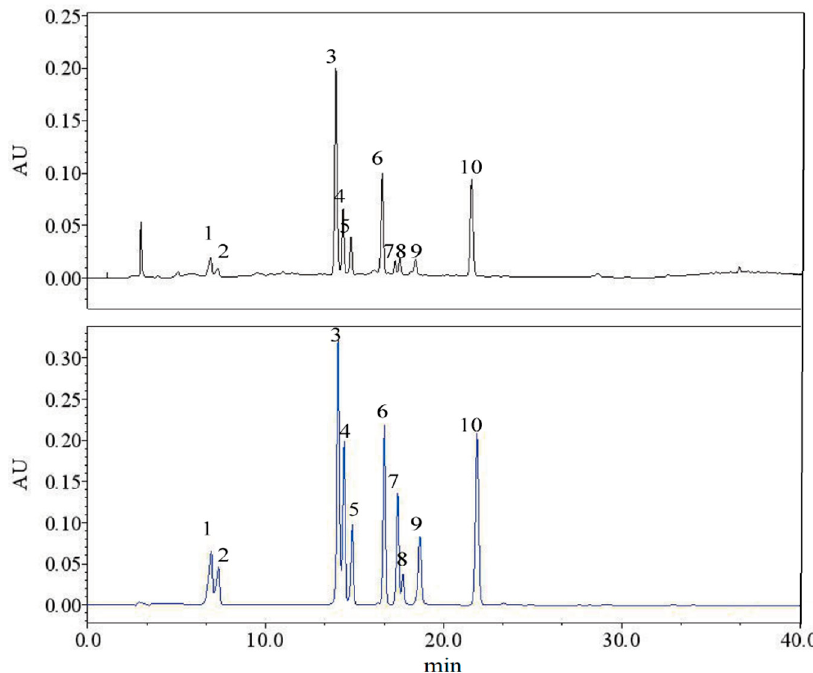
Figure 1. The representative HPLC chromatograms of C. paliurus leaf extract (top) and a mixed standards (bottom). 1. 3- O -caffeoylquinic acid; 2. 4- O -caffeoylquinic acid; 3. quercetin-3- O -glucuronide; 4. quercetin-3- O- galactoside; 5. quercetin-3- O -glucoside; 6. kaempferol-3- O - glucuronide; 7. kaempferol-3- O -glucoside; 8. quercetin-3- O -rhamnoside; 9. 4,5-di- O -caffeoylquinic acid; 10. kaempferol-3- O -rhamnoside.